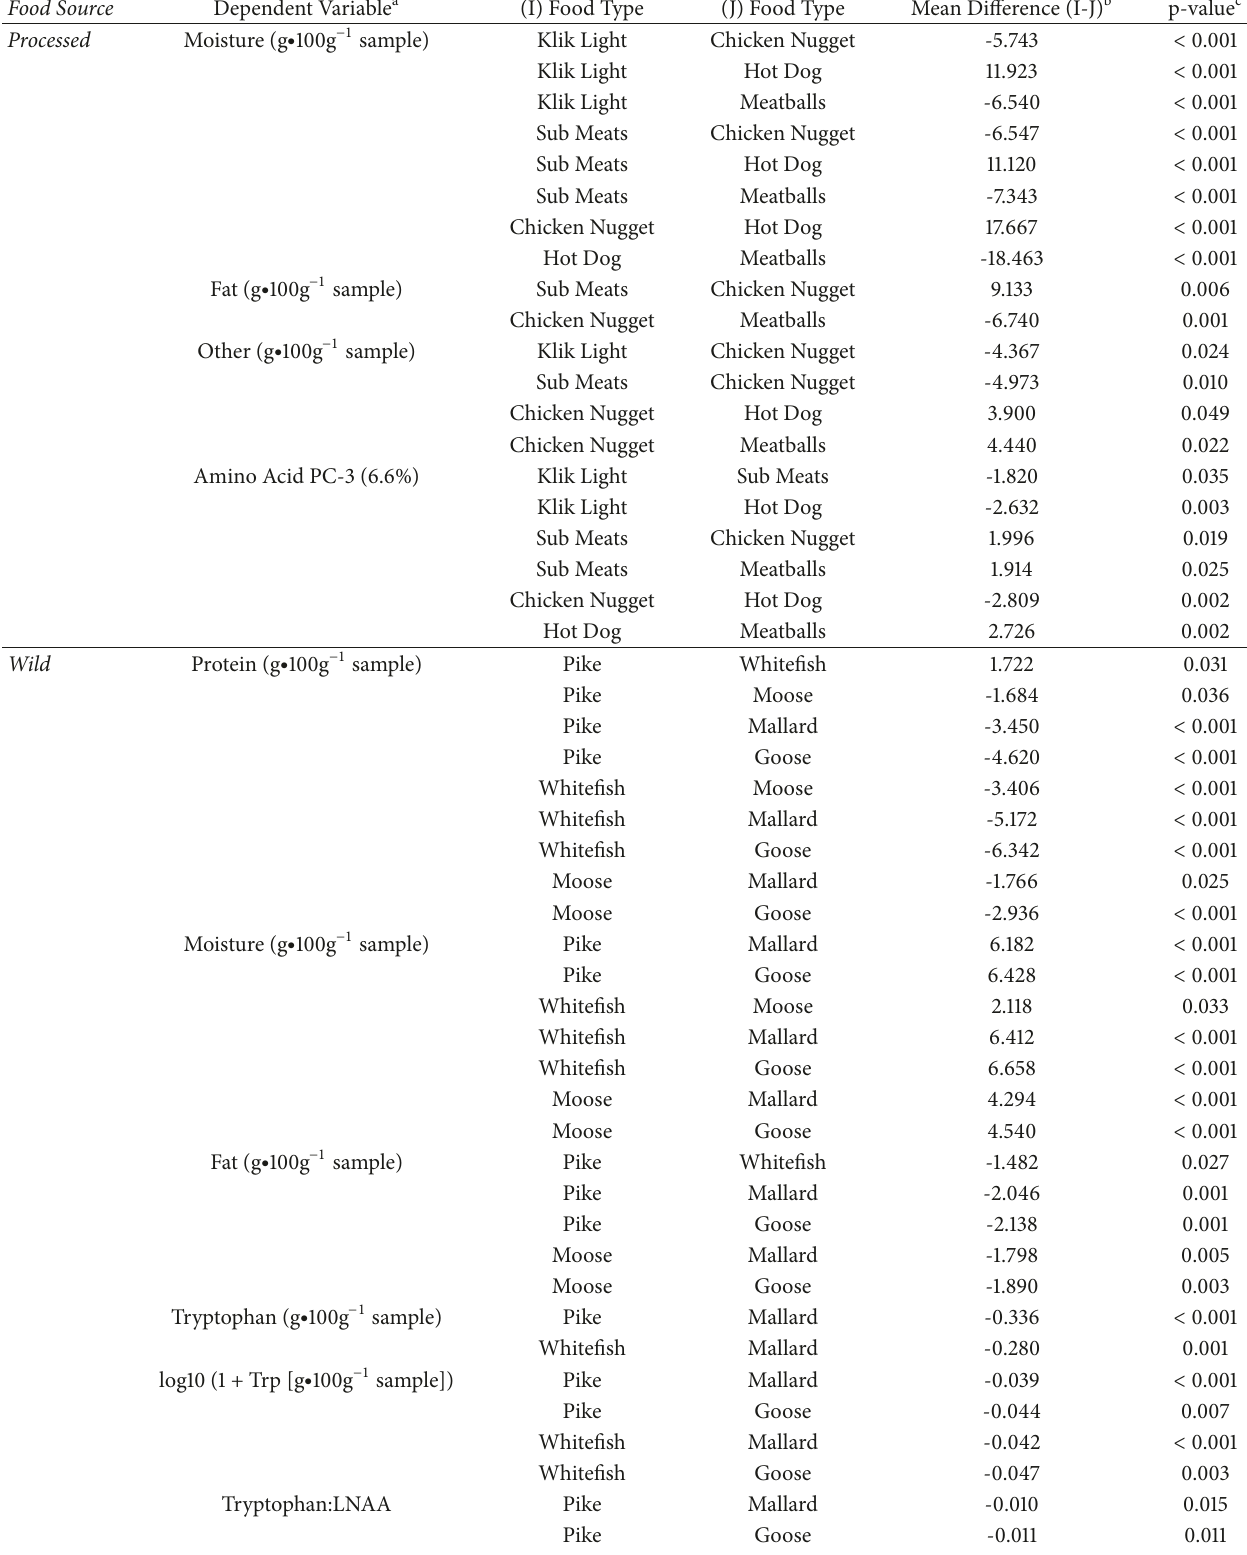
Table 11: Pair-Wise Post Hoc Comparisons of Food